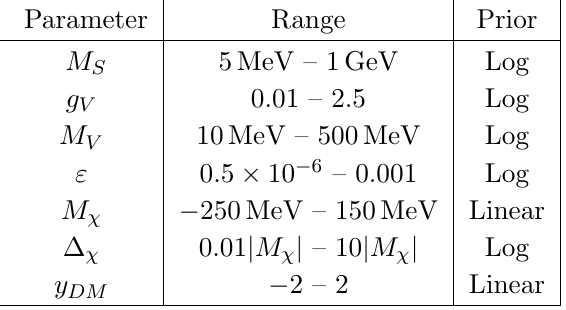
Table 2. Input parameters for the scans presented in (cid:12)gure 2.